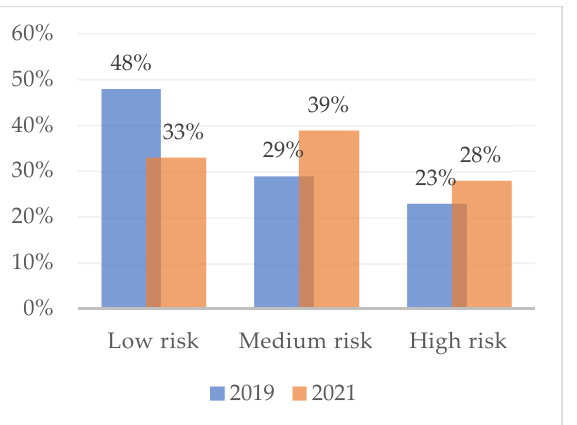
Figure 2. Risk for burnout syndrome due to personal accomplishments in February 2019 and in April 2021. n = 75.